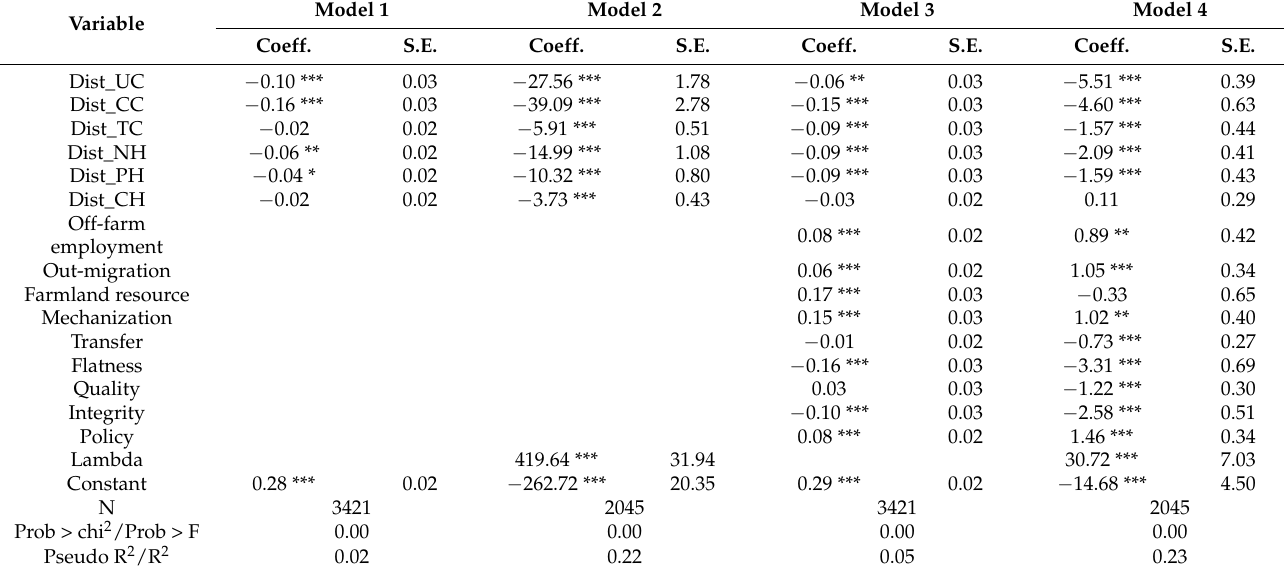
Table 3. Modeling results of farmland